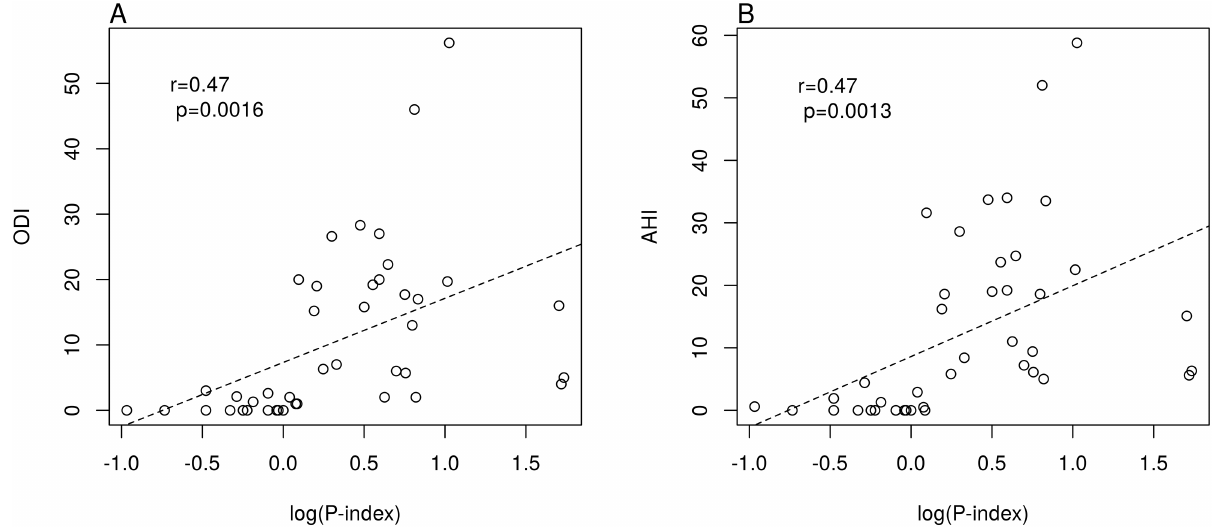
Fig 2. Correlation between cardiac parasympathetic index and diagnostic PSG indices. (A) Linear association between ODI and log (P-Index), Pearson correlation test: r = 0.47, p = 0.0016; linear model: intercept = 7.32, p < 0.001; slope = 9.81, p = 0.0016. (B) Linear association between AHI and log(P-Index), Pearson correlation test: r = 0.47, p = 0.0013; linear model: intercept = 8.60, p < 0.001; slope = 11.34, p =